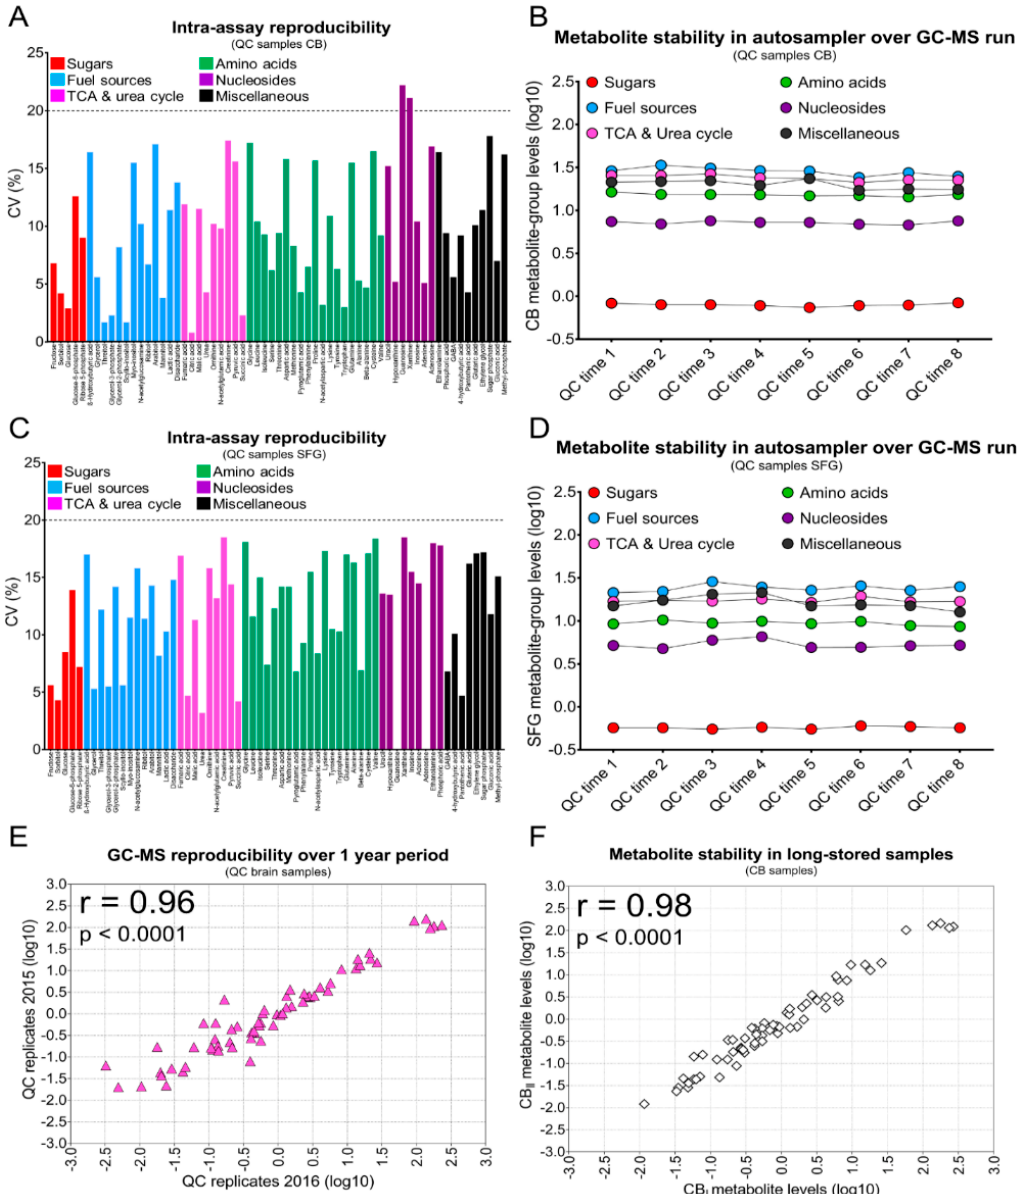
Figure 1. Reproducibility of the GC-MS assay and stability of metabolites during long-term storage. ( A , C ) Bar plots illustrate the inter-assay GC-MS reproducibility of the 63 metabolites quantified in QC samples from CB and SFG, respectively. QC replicates of pooled brain extracts were used to assess the reproducibility of measurements. For each metabolite, the coe ffi cient of variation (%) is shown in individual brain regions. ( B , D ) Dot plots showing how stable the metabolite groups are in QC samples over a GC-MS sequence run of ~43 h. In this study, eight QC replicates were used for reproducibility assessment and metabolite stability investigation of CB and SFG samples. A total of 16 human brain samples homogenates were used to perform reproducibility and stability assessment. ( E ) Individual scatterplots showing the correlation between metabolites measurements in QC replicates analysed by GC-MS in 2015 ( n = 12) and 2016 ( n = 12). Pearson’s correlation coe ffi cients ( r ) and corresponding p -values are shown at the top-left in each scatterplot panel and reported metabolite values have been log 10 -transformed. ( F ) Individual scatterplots showing the correlation between metabolites measurements in long-stored brain tissue CB biological replicates extracted in 2015 and 2016 respectively and analysed by GC-MS. Pearson’s correlation coe ffi cients ( r ) and corresponding p -values are shown at the top-left in each scatterplot panel and reported metabolite values have been log10-transformed.